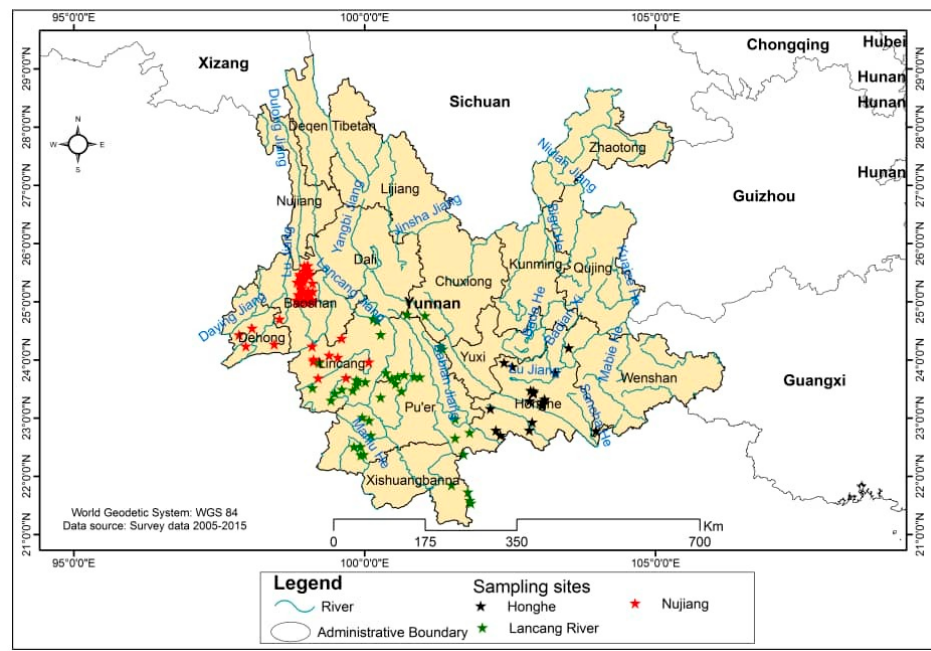
Figure 1. Collection sites of the mango germplasm resources in China.